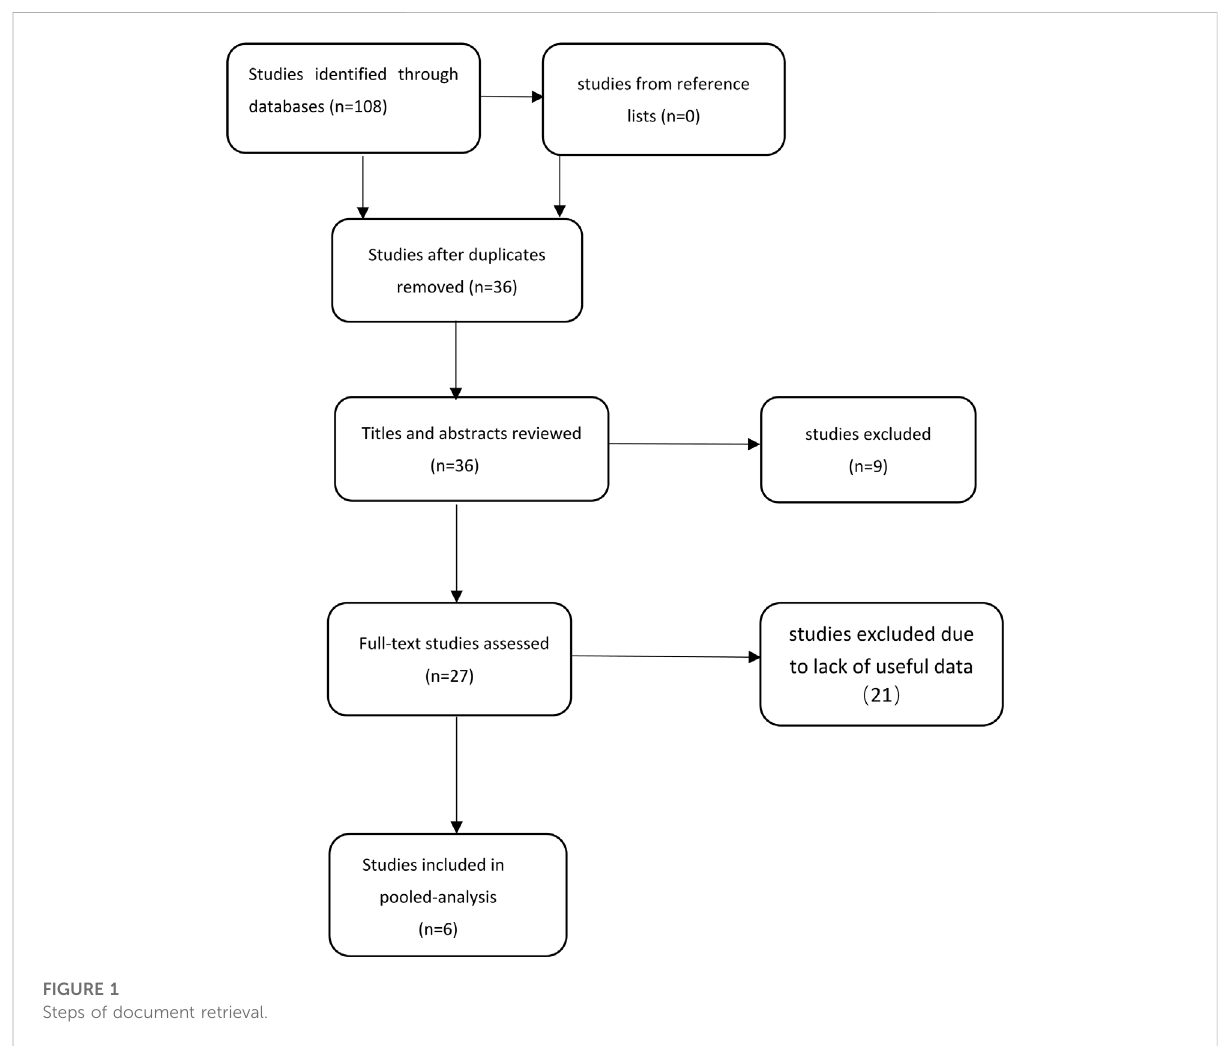
FIGURE 1 Steps of document retrieval.